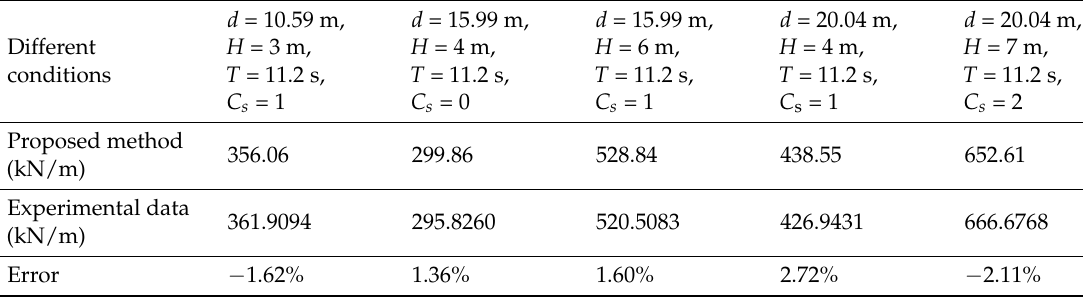
Table 2. Comparison of maximum vertical wave forces on box girder by proposed method and experimental data under same